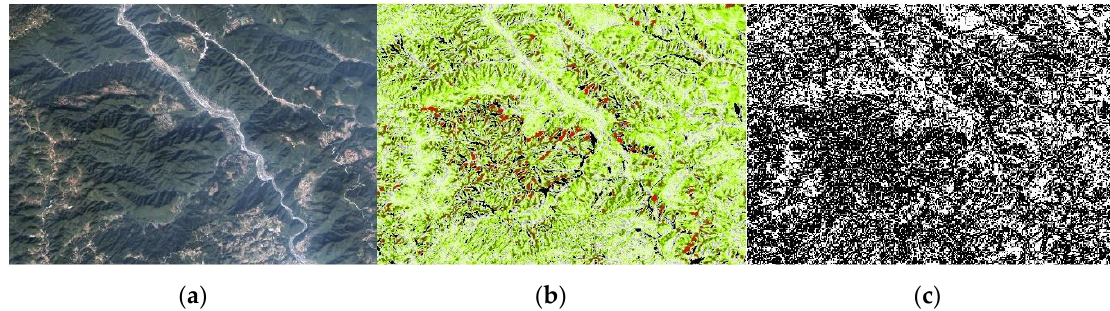
Figure 7. The slope difference mask. Subgraph ( a ) shows the ZY-3 multi-spectral image of the demonstration area. Subgraph ( b ) shows the crude CHM that was contaminated by terrain fluctuations (the legend is the same as Figure 5’s). Subgraph ( c ) shows the slope difference mask. We only preserved the areas with slope differences less than 4.5° (displayed in white). The 4.5° threshold was a compromise option to minimize the interferences from terrain, while retaining enough samples.